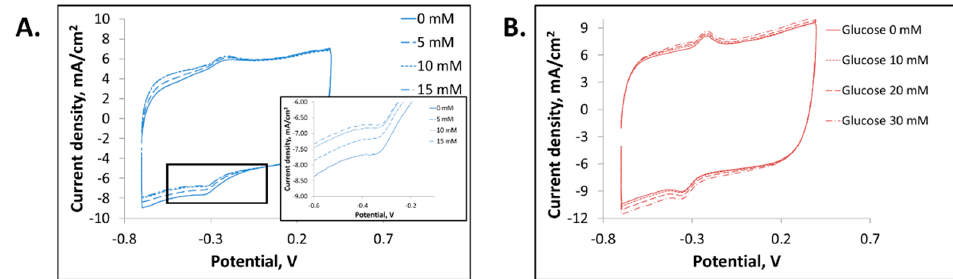
Figure 3. GOx activity evaluation in the presence of increasing concentrations of glucose using ( A ) Chitosan-modified bioelectrode (LDG-CH10) and ( B ) PBS modified bioelectrode (LDG-PBS10) treated with KCl. Voltammograms acquired at 0.1 V/s.